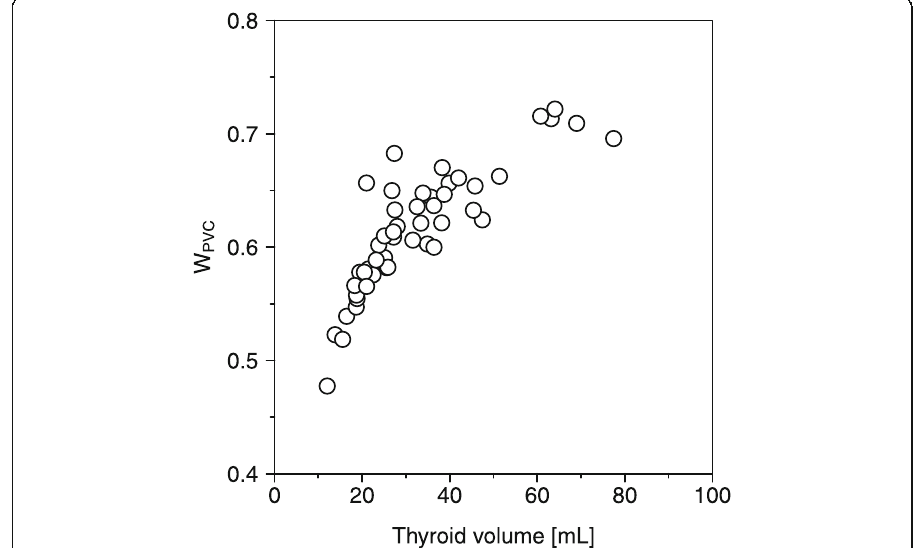
Fig. 5 Relationship between weighting factor, W PVC , used for partial volume correction and thyroid volume